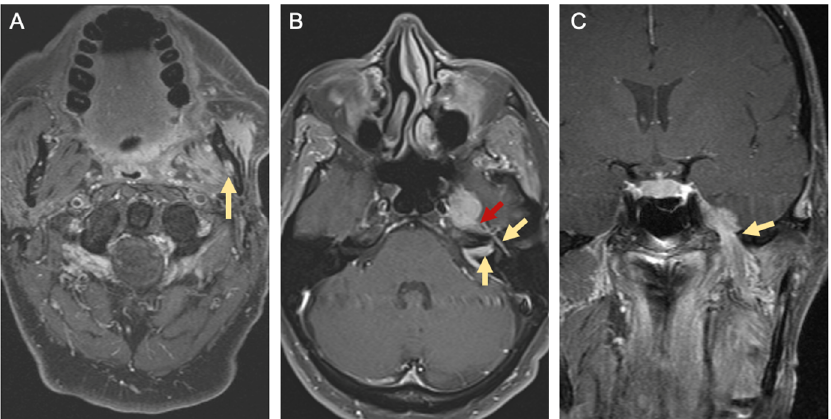
Figure 2. Radiographic signs of perineural spread. T1-weighted magnetic resonance (MR) images with gadolinium from a patient with left buccal squamous cell carcinoma and perineural invasion. ( A ) Axial image showing enlargement and enhancement of the left inferior alveolar canal (yellow arrow). ( B ) Axial image showing enhancement of the intracanalicular and tympanic segments of the facial nerve (yellow arrows) as well as the greater superficial petrosal nerve (red arrow). ( C ) Coronal image showing enlargement and tumor involvement of the mandibular branch of the left trigeminal nerve at the foramen ovale (yellow arrow).